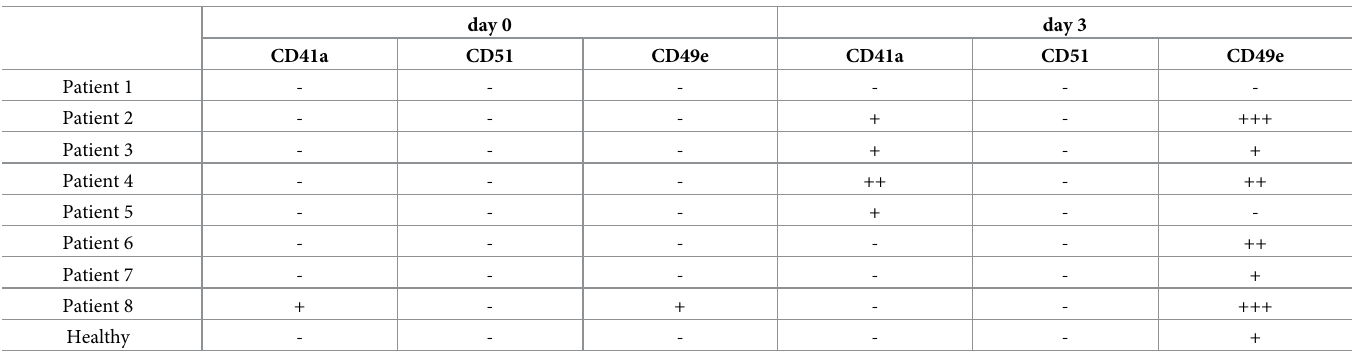
Table 1. Expression of CD41a, CD51 and CD49e on freshly isolated CLL B cells and on the 3 rd day of culture.